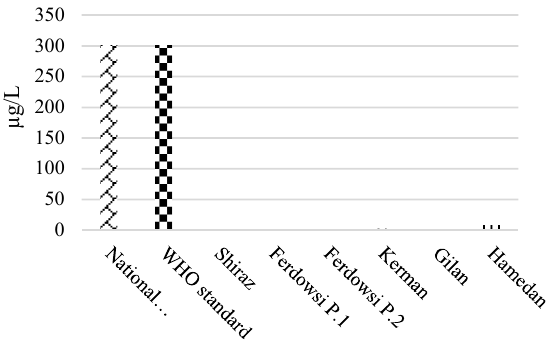
Fig. 8. Comparison of the amount of dibromochloromethane to the national and global standard